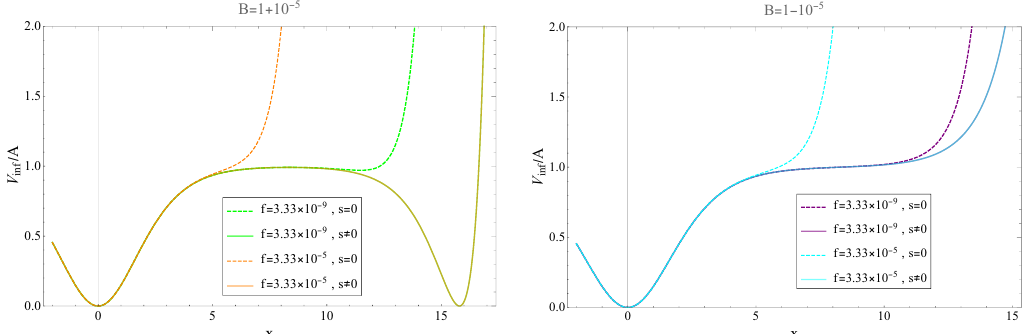
with A = 3 × 10 − 10 , λ = 0 . 5 , s 6 = 0 and s = 0 for the solid Figure 4 . The inflation potential V inf 2 A and dashed curves respectively, and we took two values for f = 3 . 33 × 10 − 9 and 3 . 33 × 10 − 5 . The left panel corresponds to B = 1+10 − 5 and the right panel corresponds to B = 1 − 10 − 5 . All values are given in the units where M = 1 P